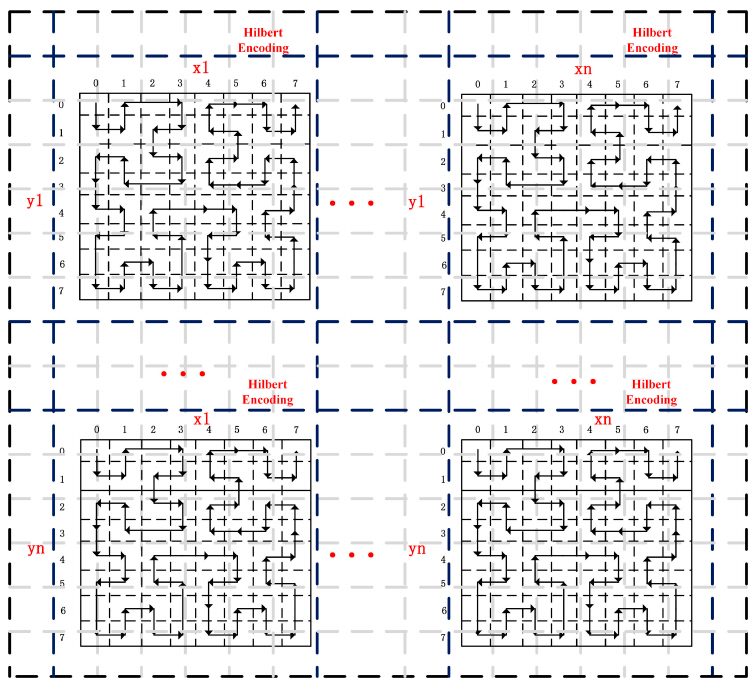
Figure 2. Hilbert encoding process in the HDFS data blocks.